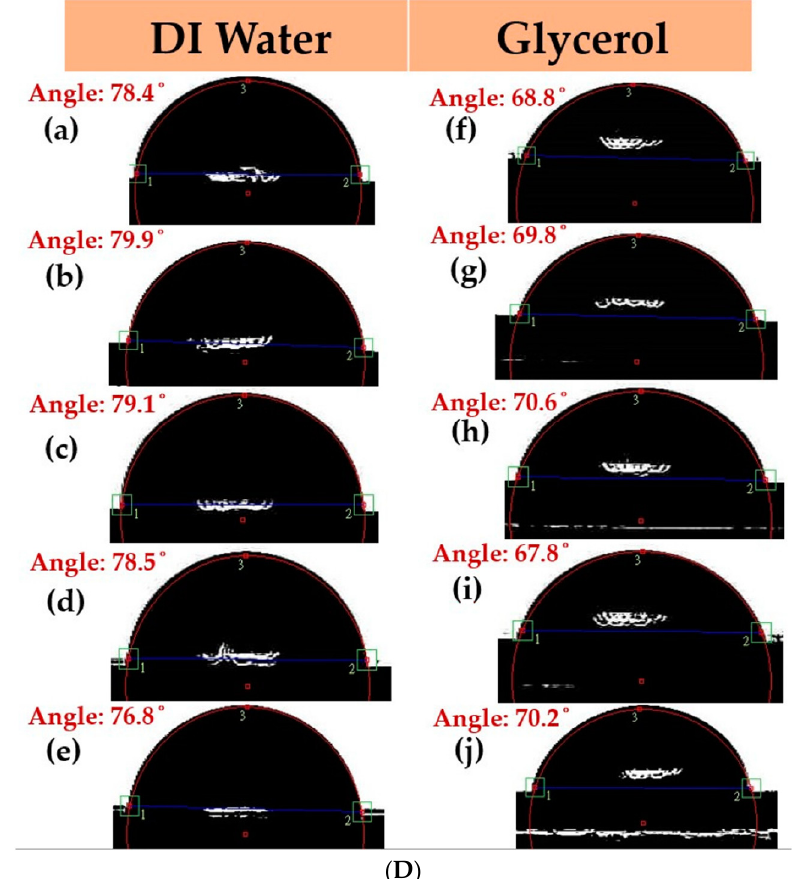
Figure 5. Contact angles of the CoFeYb thin films: ( A ) RT, ( B ) after annealing at 100°C, ( C ) after annealing at 200°C, ( D ) after annealing at 300°C. DI water: ( a ) 10 nm, ( b ) 20 nm, ( c ) 30 nm, ( d ) 40 nm, and ( e ) 50 nm. Glycerol: ( f ) 10 nm, ( g ) 20 nm, ( h ) 30 nm, ( i ) 40 nm, and ( j ) 50 nm.